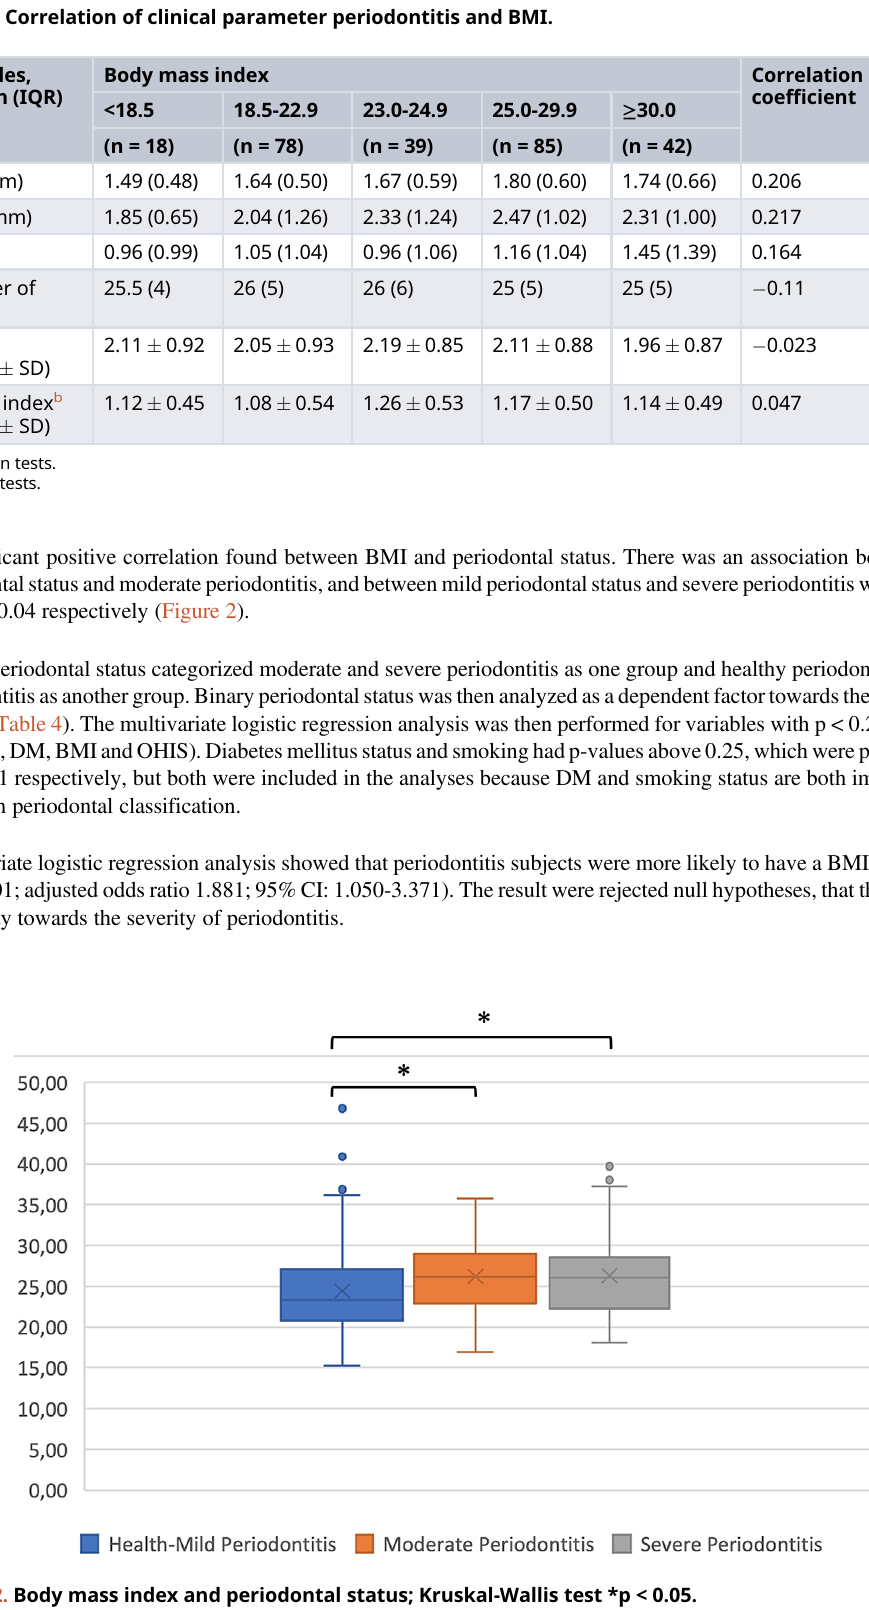
Table 3. Correlation of clinical parameter periodontitis and BMI.